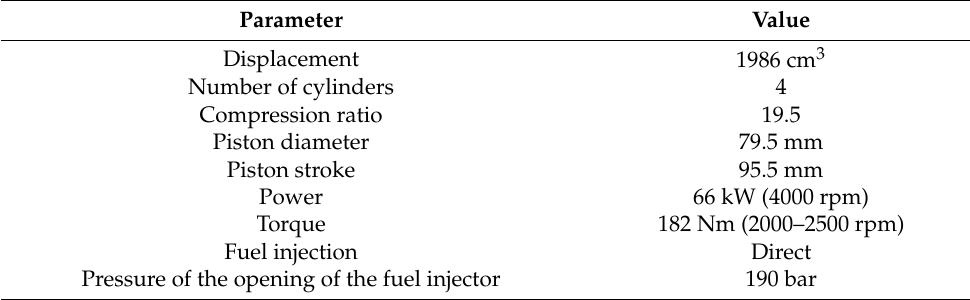
Table 1. The main parameters of the compression ignition